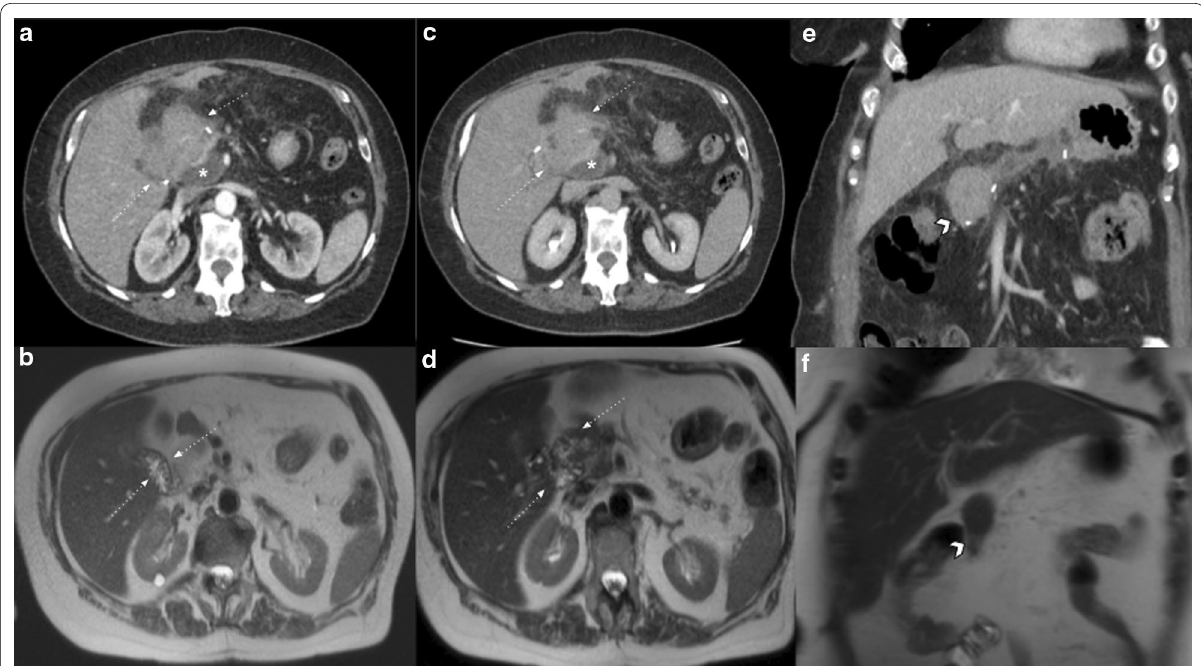
Fig. 11 Collapsed loop vs tumor recurrence. The MRI role. 62-year-old female patient during routine follow-up after pancreaticoduodenectomy due to pancreatic adenocarcinoma three months early. ( a , c , e ) Axial and coronal view contrast-enhanced CT scan. Homogeneous fluid collection (asterisk) in the surgical bed and related to an ill-defined soft tissue enhancing image with peripheral fat stranding associated (dotted arrows). Coronal view denotes a pseudo-mass image (arrowhead in c ). Collapsed loop versus inflammatory changes were suggested as possible diagnosis, so strict control was indicated. ( b , d , f ) MRI performed two months later. Prior collection complete resolution. The ill-defined image related to the hepatic hilum is now better defined as the collapsed loop due to their fluid content and intestinal folds (dotted arrow). Coronal view denotes the blind portion of the afferent loop as the previously described pseudo-mass image (arrowhead in f